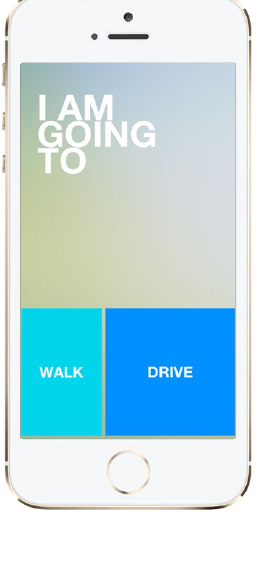
Fig. 13. U.I. drive or walk screen